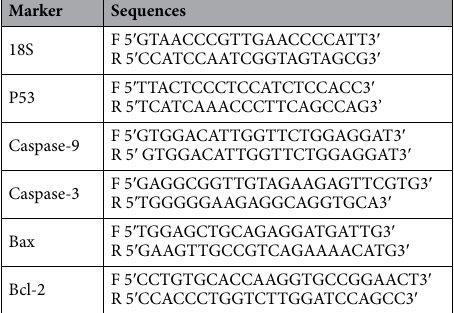
Table 1. Sequences of primers used in RT-PCR assays. Bax Bcl-2 associated X protein.